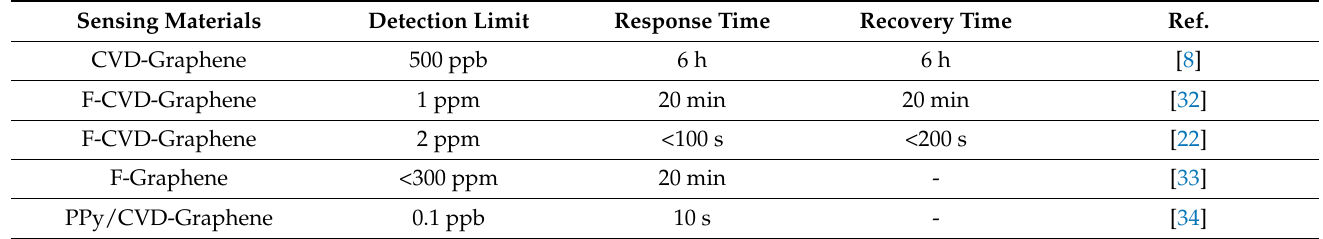
Table 1. Graphene-based gas sensors for NH 3 detection at room